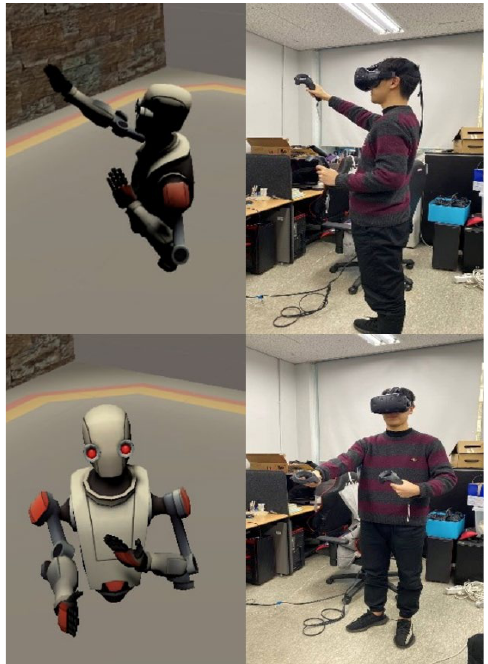
Figure 6. Comparison of the virtual reality(VR) user ( right ) and the corresponding self-avatar using our method ( left ).